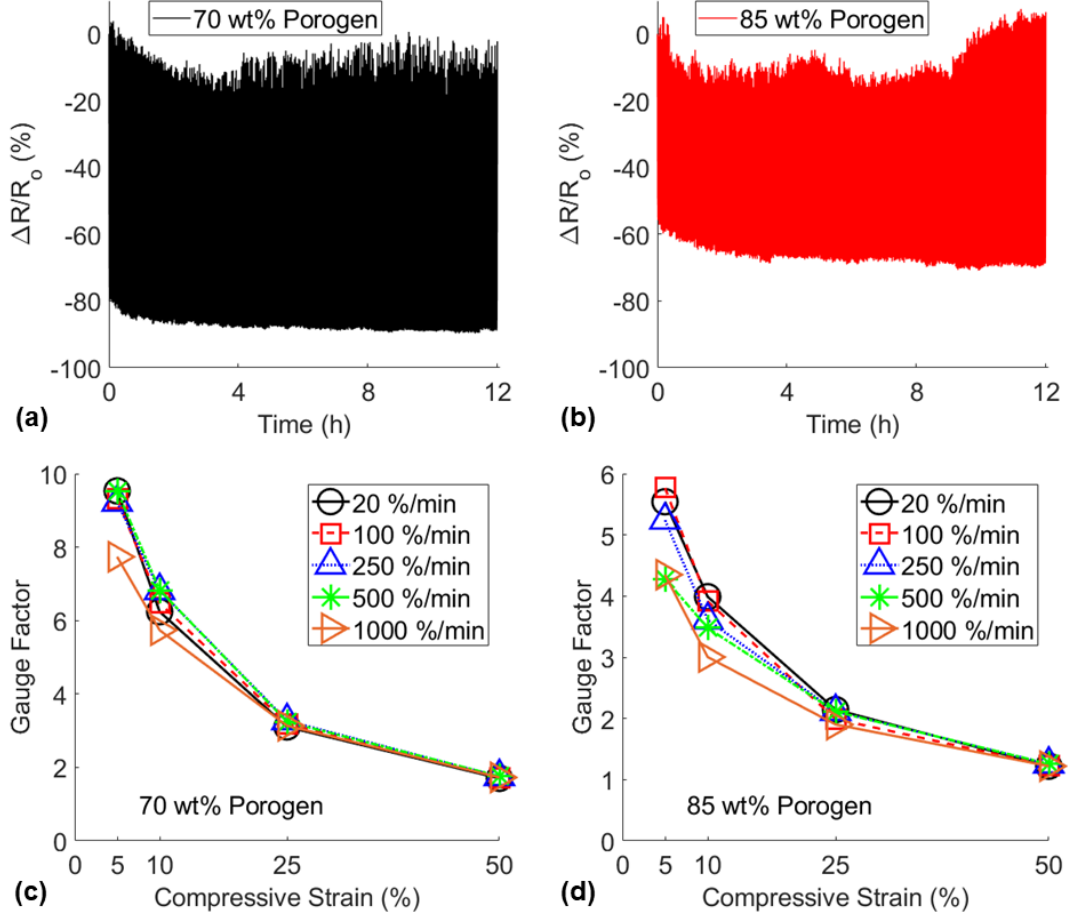
Figure 8. Piezoresistive signals for the 360-cycle durability test to compare ( a ) CNT3P70 and ( b ) CNT3P85 sensors and gauge factors at each compressive strain for varying strain rates (20 %/min–1000 %/min) to compare ( c ) CNT3P70 and ( d ) CNT3P85 sensors.